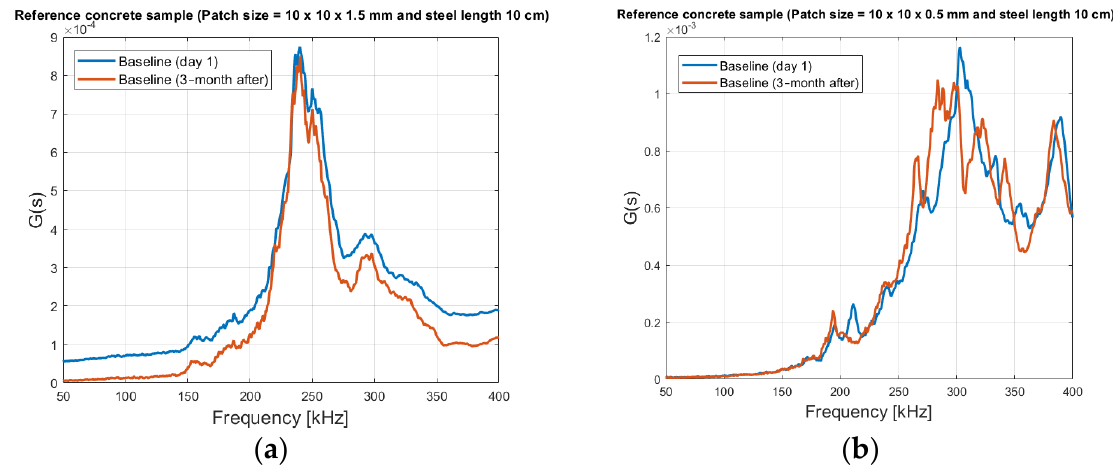
Figure 20. Reference concrete with steel rod with length of 10 cm ( a ) Patch Size of 10 × 10 × 1.5 mm and ( b ) Patch Size of 10 × 10 × 0.5 mm.